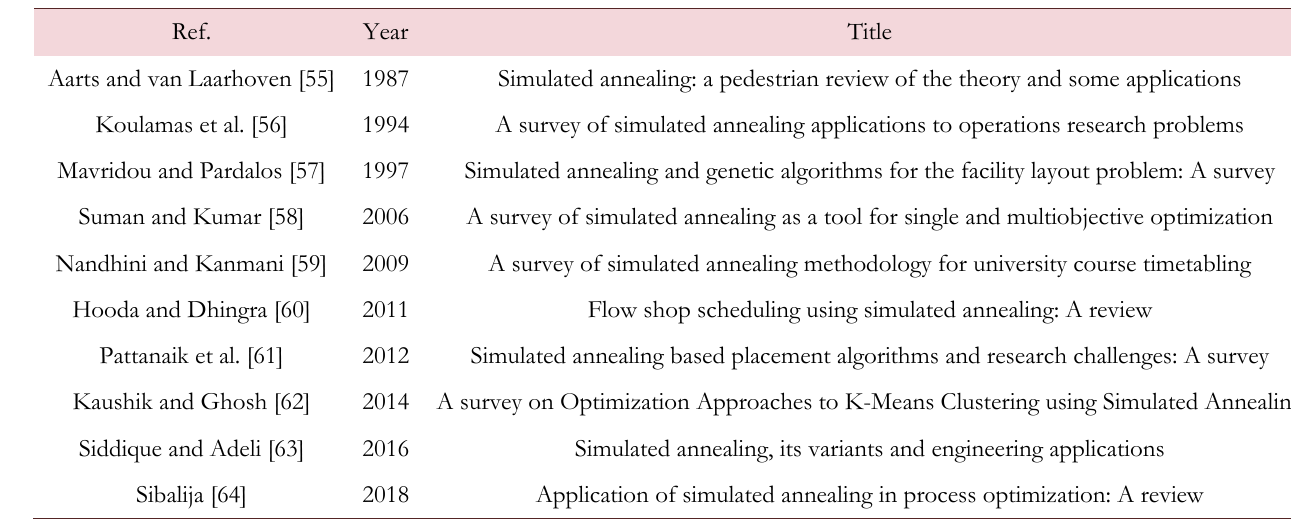
Table 1: List of review papers on applications of SA algorithm in various fields.